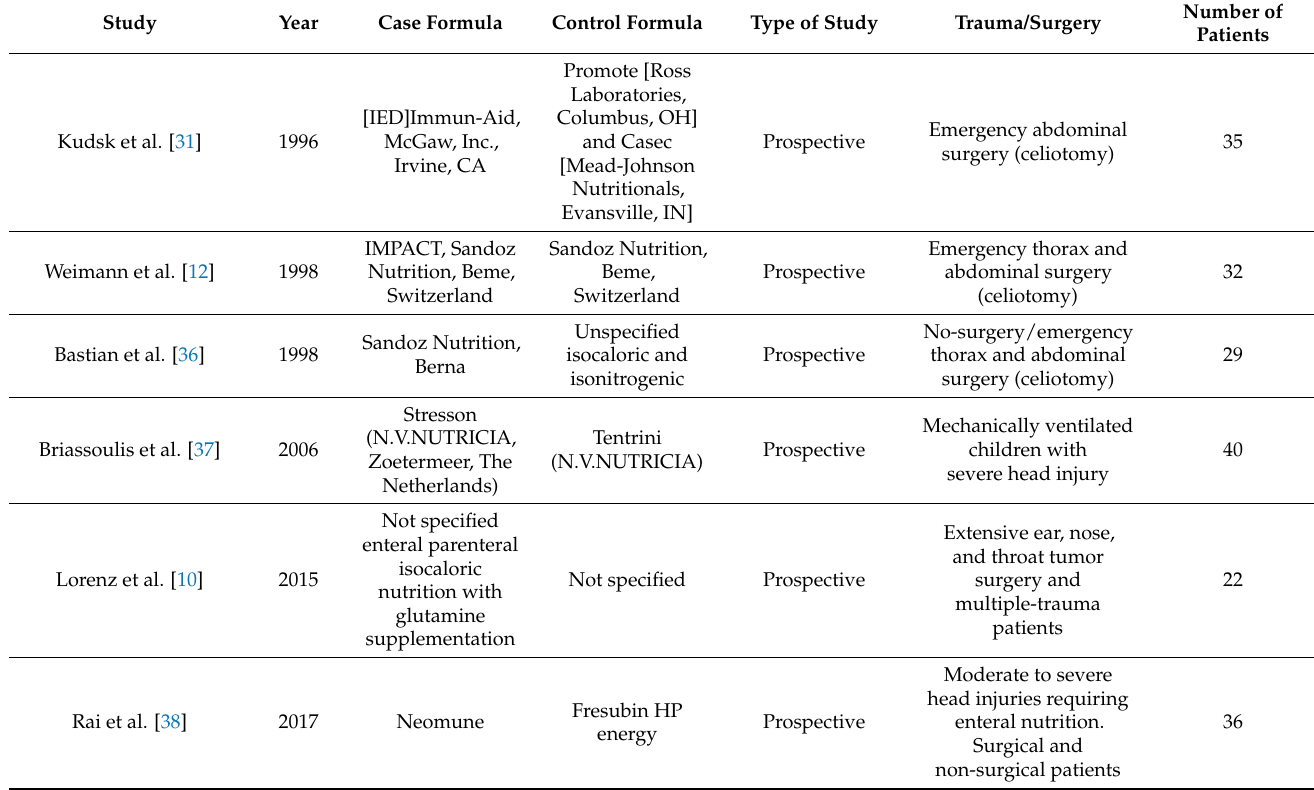
Table 1. Non-elective traumatic